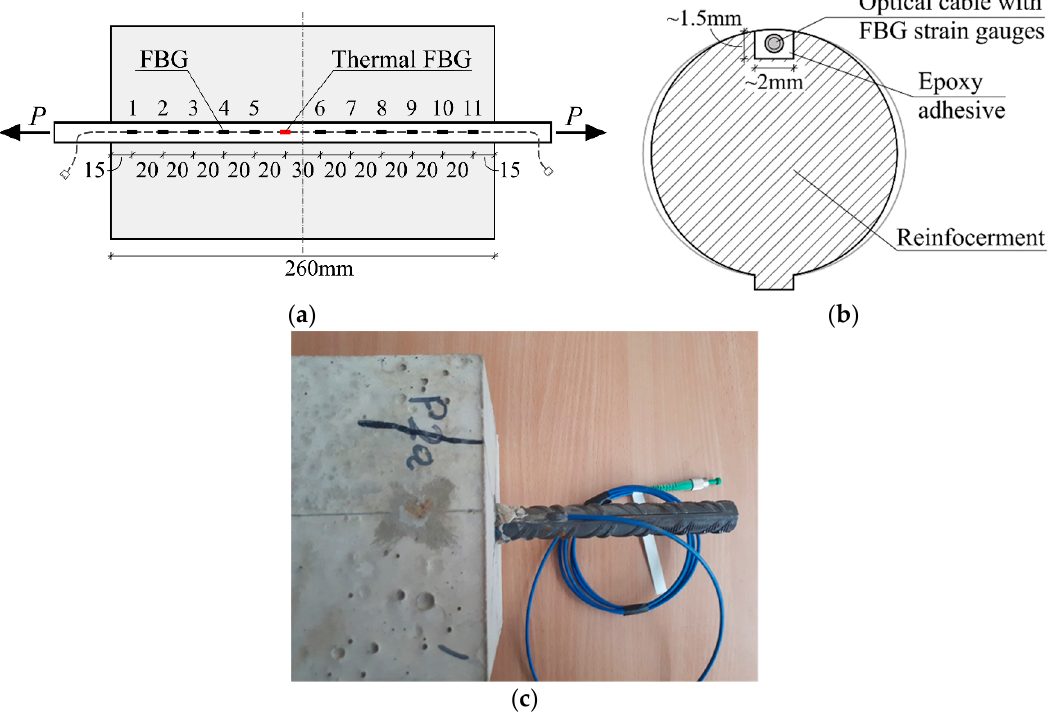
Figure 2. Installation and spacing of fiber Bragg grating sensors: ( a ) Longitudinal layout; ( b ) sectional view of the reinforcement bar; ( c ) enlarged view of a fragment of the test specimen.